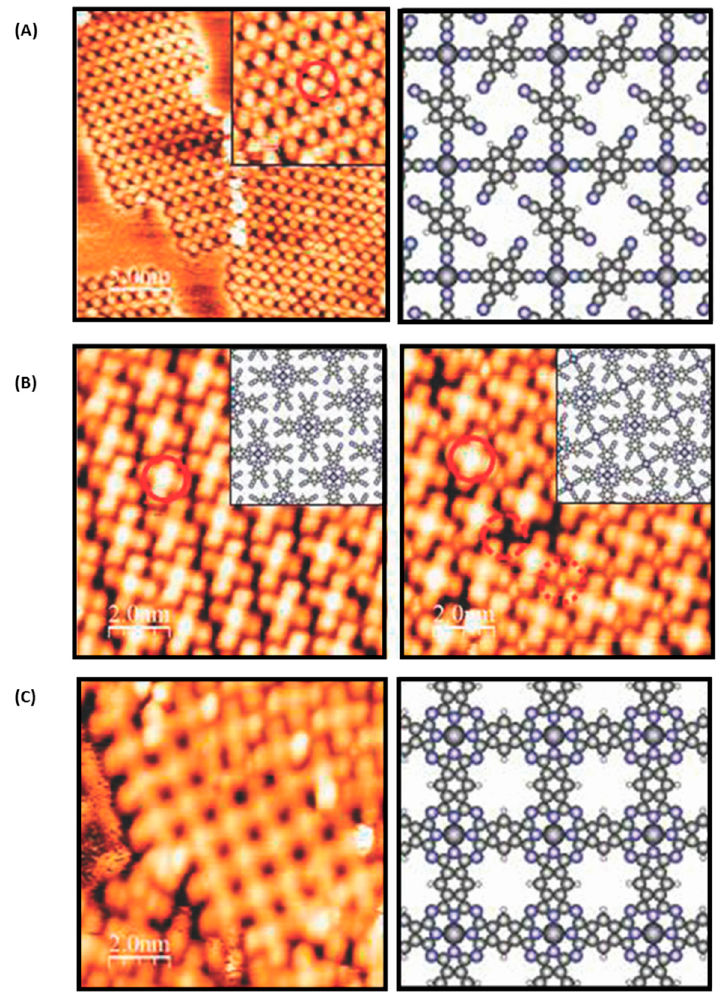
Figure 17. The different steps involved in the formation of phthalocyanines-based 2D π -conjugated polymers. ( A ) STM images of the supramolecular phase resulting from the deposition of 1,2,4,5- tetracyanobenzene (TCNB) and Mn atoms on a Ag(111) surface at room temperature with a DFT model. ( B ) STM images of the two phases existing after annealing at 277 °C. Left: the hydrogen-bonded supramolecular phase. Right: the metal–organic coordination 2D polymers. ( C ) Polymeric phase obtained in the final step upon annealing at 342 °C. Reproduced from [98] with permission from The Royal Society of Chemistry.